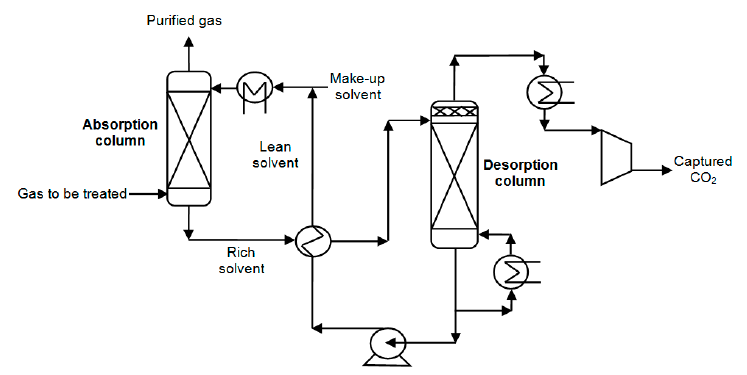
Figure 1. CO 2 capture by chemical scrubbing via an absorption-desorption cycle.